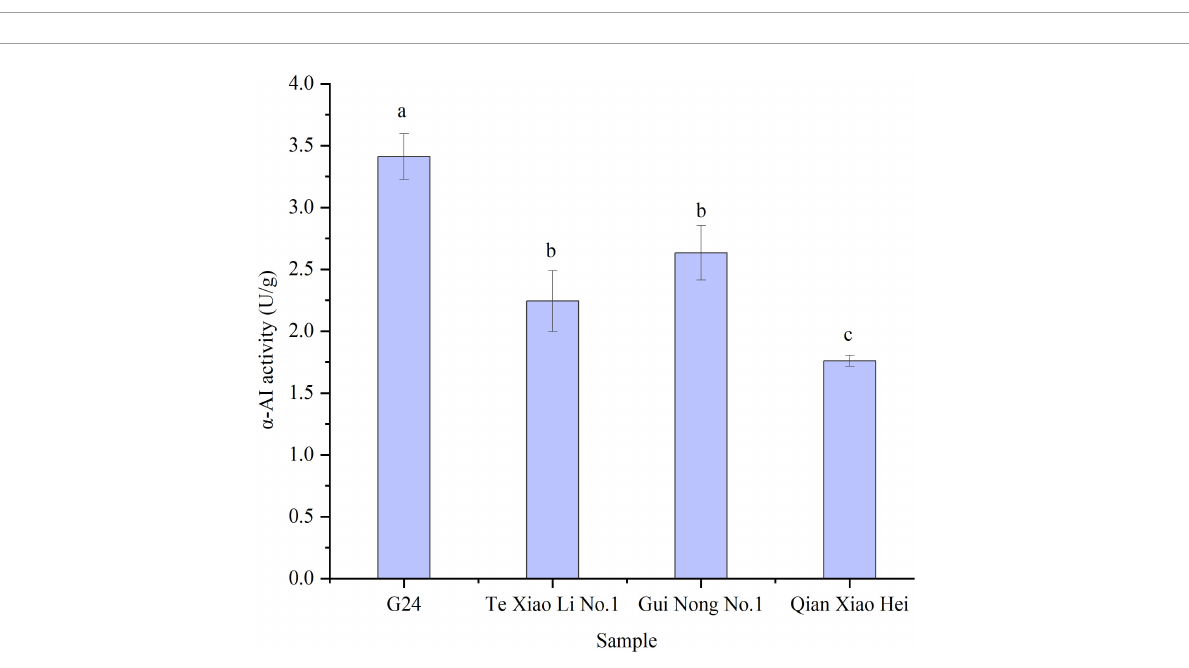
FIGURE3 The α -AI specific activities of adzuki beans. Bars with no same letters indicate significant differences at the level of p <